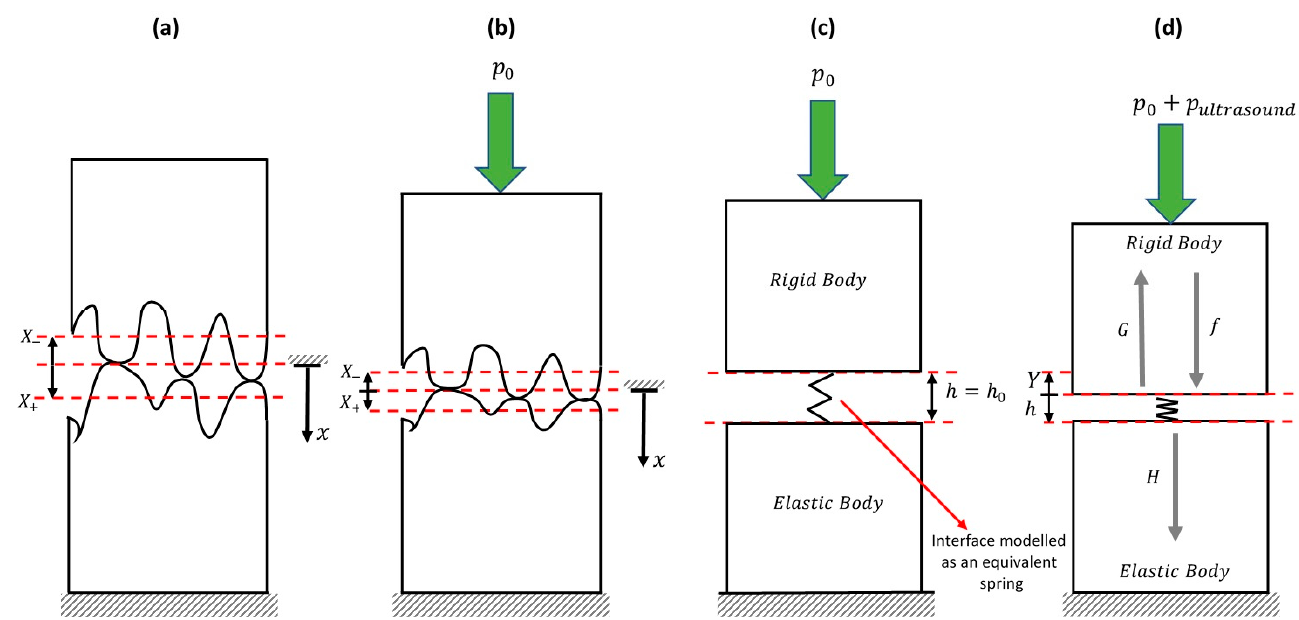
Figure 1. Schematic diagram of the asperity junctions and ultrasonic wave propagation through the media: ( a ) aluminium blocks and aspeiry contact in the absence of normal load; ( b ) origin and direction of the positive propagation axis; ( c ) contacting surfaces in the absence of elastic wave under static equilibrium contact; ( d ) relative surface approach and surface separation due to propagating elastic wave.